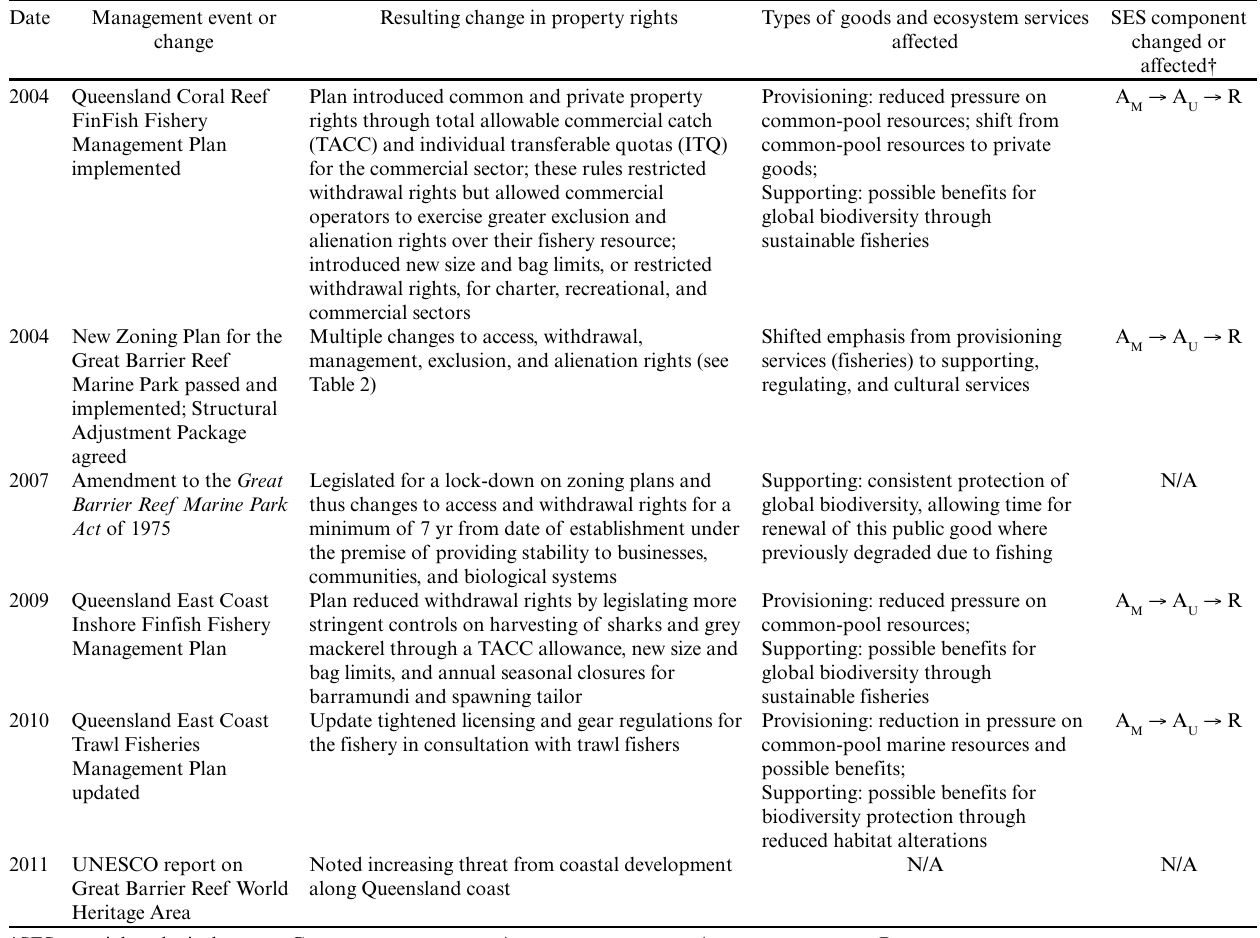
Table 4. Major management changes through time for the Great Barrier Reef Marine Park, and resulting property rights changes: rezoned system, 2004 to